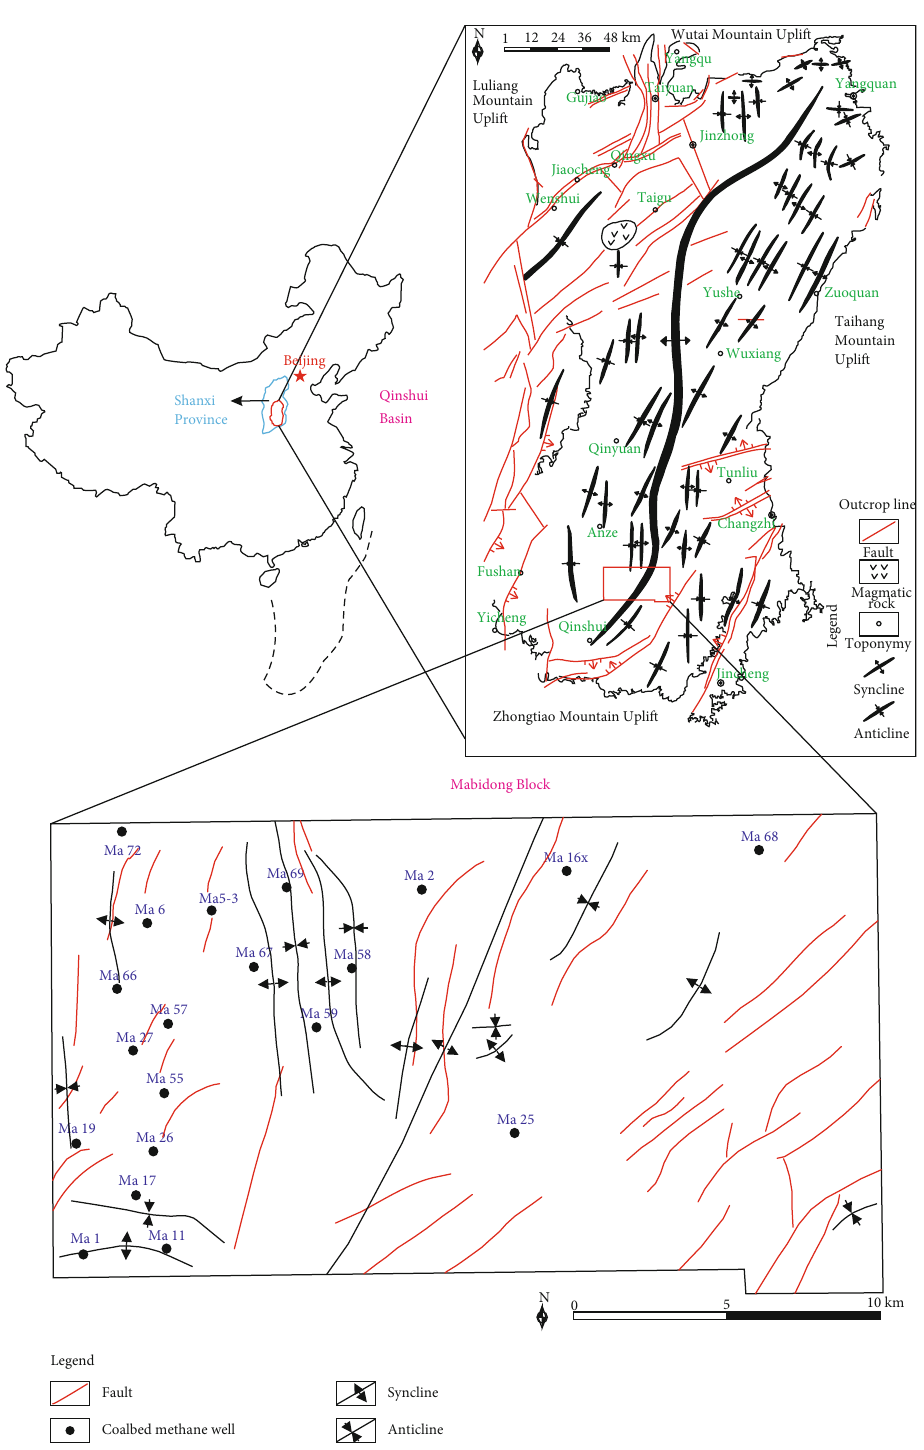
Figure 1: Map of the Mabidong block showing major structures and locations (modi fi ed from